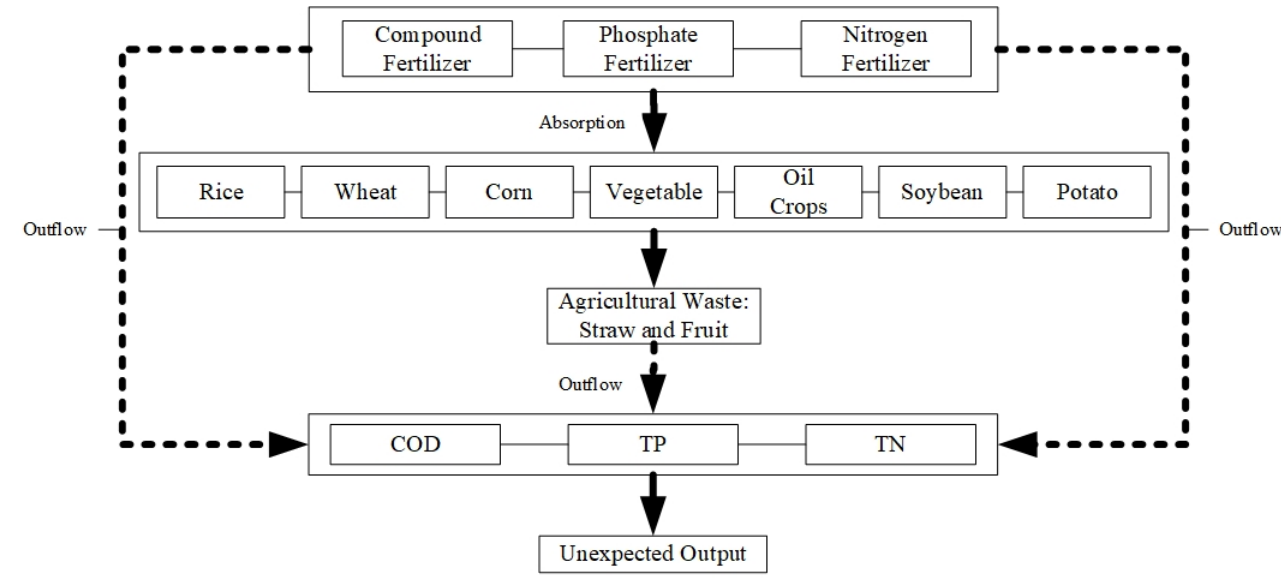
Figure 1. Unexpected output production system.